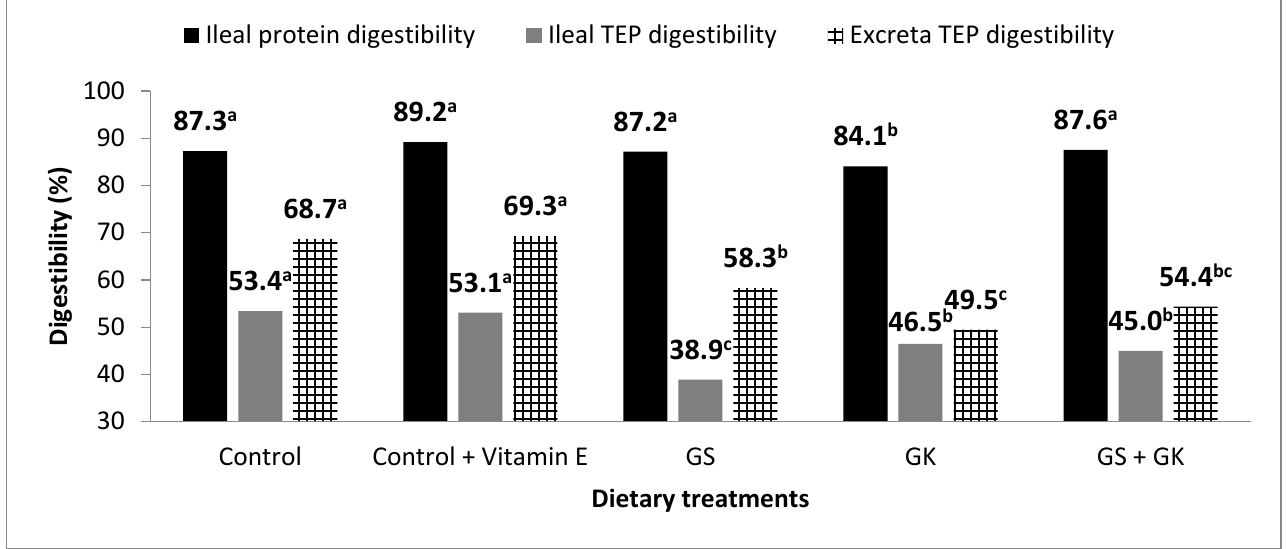
Figure 1. Ileal digestibility of protein (SEM 1 = 0.535, *) and ileal (SEM = 1.37, ***) and excreta (SEM = 2.16, ***) digestibility of total extractable polyphenols (TEP) in broiler chickens fed diets containing grape seed (GS) meal, grape skin (GK) meal or vitamin E. Different letters for the same parameter ( a, b, c ) indicate significant differences ( p < 0.05). 1 SEM, standard error of means; each value represents the mean of five replicates (three birds per replicate for ileum and six birds per replicate for excreta). * p < 0.05, *** p < 0.001.